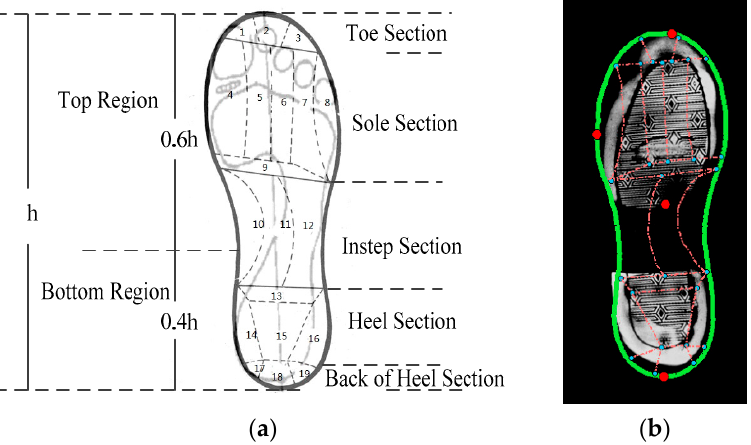
Figure 5. Illustration of the shoeprint partition model. ( a ) The layout of 19 subsections of a shoeprint; ( b ) Example of the Shoeprint Partition Model (SPM) for a full shoeprint.